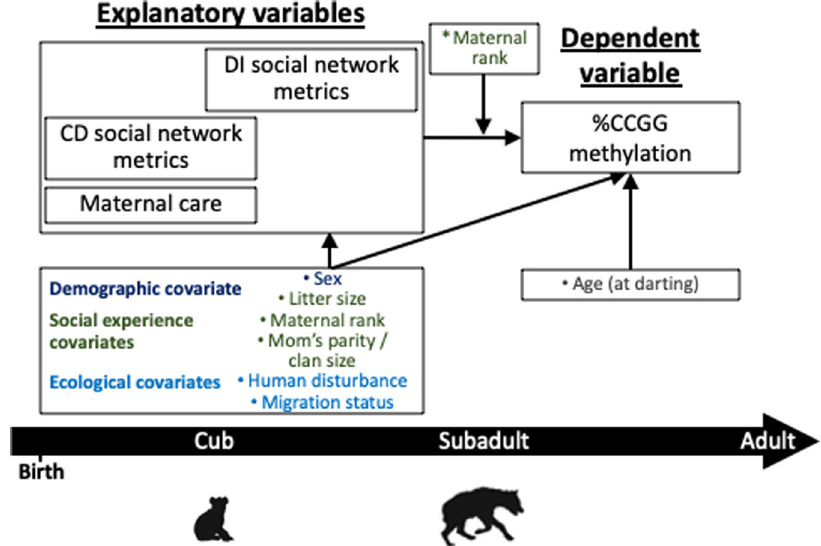
Fig. 5 Directed acyclic graph (DAG) for Part 2 of the analysis showing the hypothesized relationships between early-life social experiences and % CCGG methylation. Potential confounding variables were modeled in three different context groups, which included demographic covariates (dark blue), early social experience covariates (dark green), and ecological covariates (light blue). *Maternal rank was considered a potential effect modi fi er of the associations of interest. Age at darting was included as a precision covariate. Variable positions over the timeline roughly corresponded with the timing of the assessment.